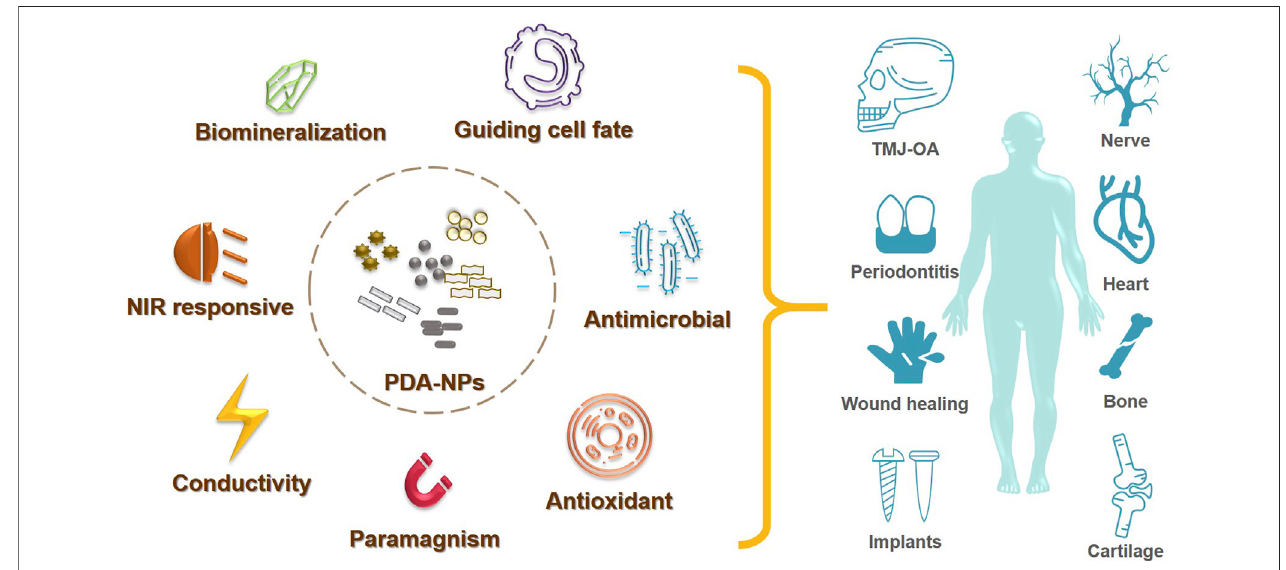
FIGURE 1 | Schematic of PDA-NPs in TE